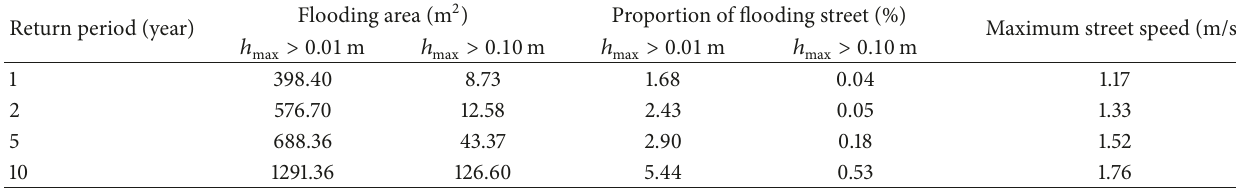
Table 7: Details of ground surface